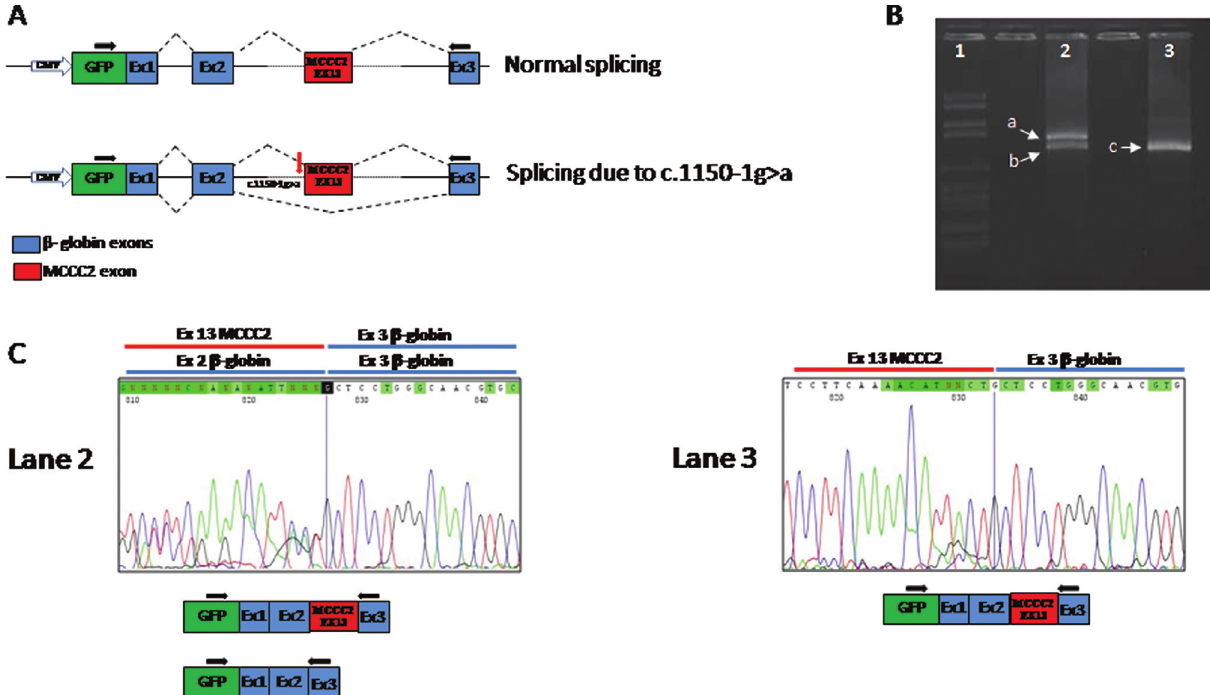
Figure 4 - Minigene construct and RT-PCR results obtained in expression studies. (A) The minigene construct (pMGene) used in the study: a DNA frag- ment of approximately 1 kb was directly amplified from the genomic DNA of the patient and cloned into the pMGene as decribed in the Results section. All clones were sequenced, and a wild-type and a mutated clone were used for expression experiments. (B and C) The splicing pattern, evaluated by RT-PCR and sequence analysis of mRNA extracted from cell lines transfected with WT or mutated minigene constructs. Lane 1: molecular weight marker, lane 2: RT-PCR of RNA obtained using the mutant clone; lane 3: RT-PCR of RNA obtained from the normal